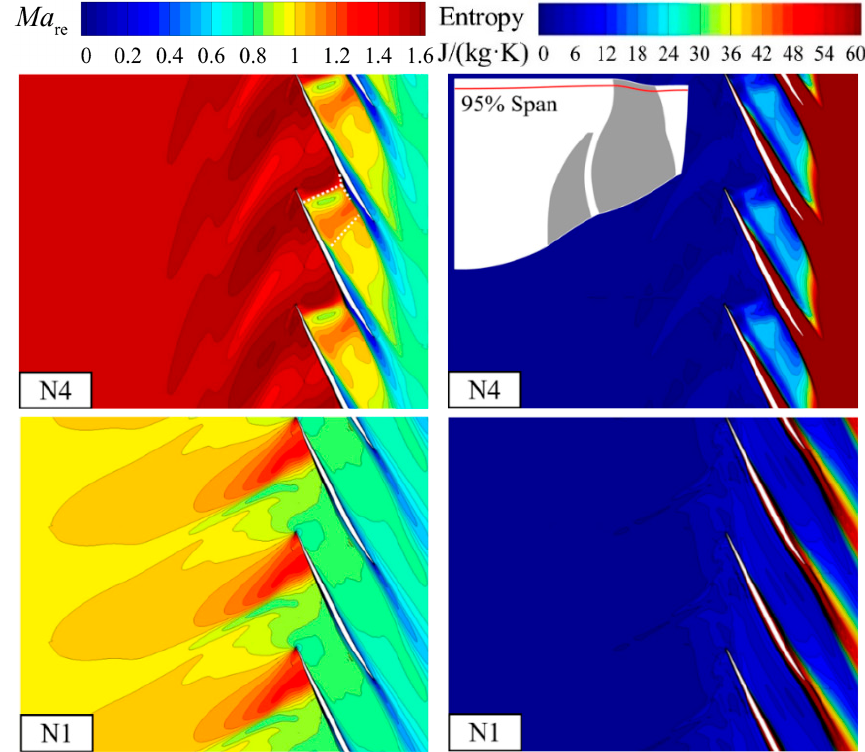
Figure 18. Ma re and entropy contour at 95% span of the tandem rotor.